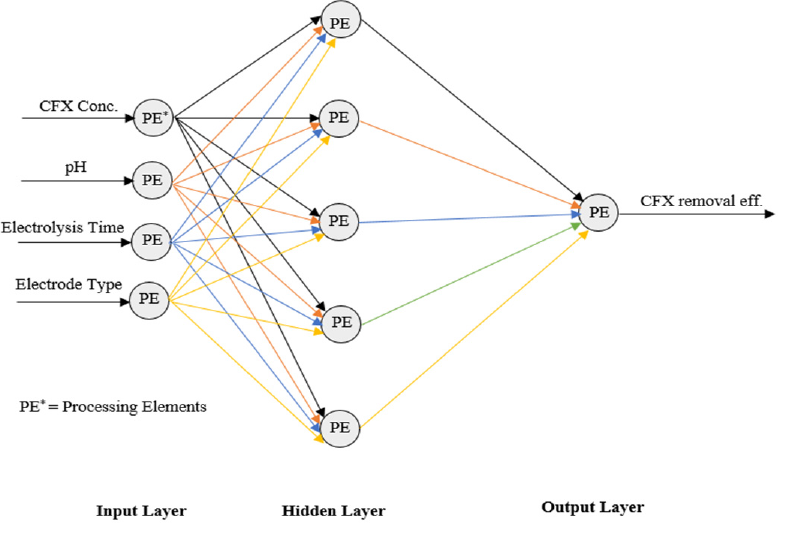
Figure 2. ANN Figure 2. ANN Architecture.